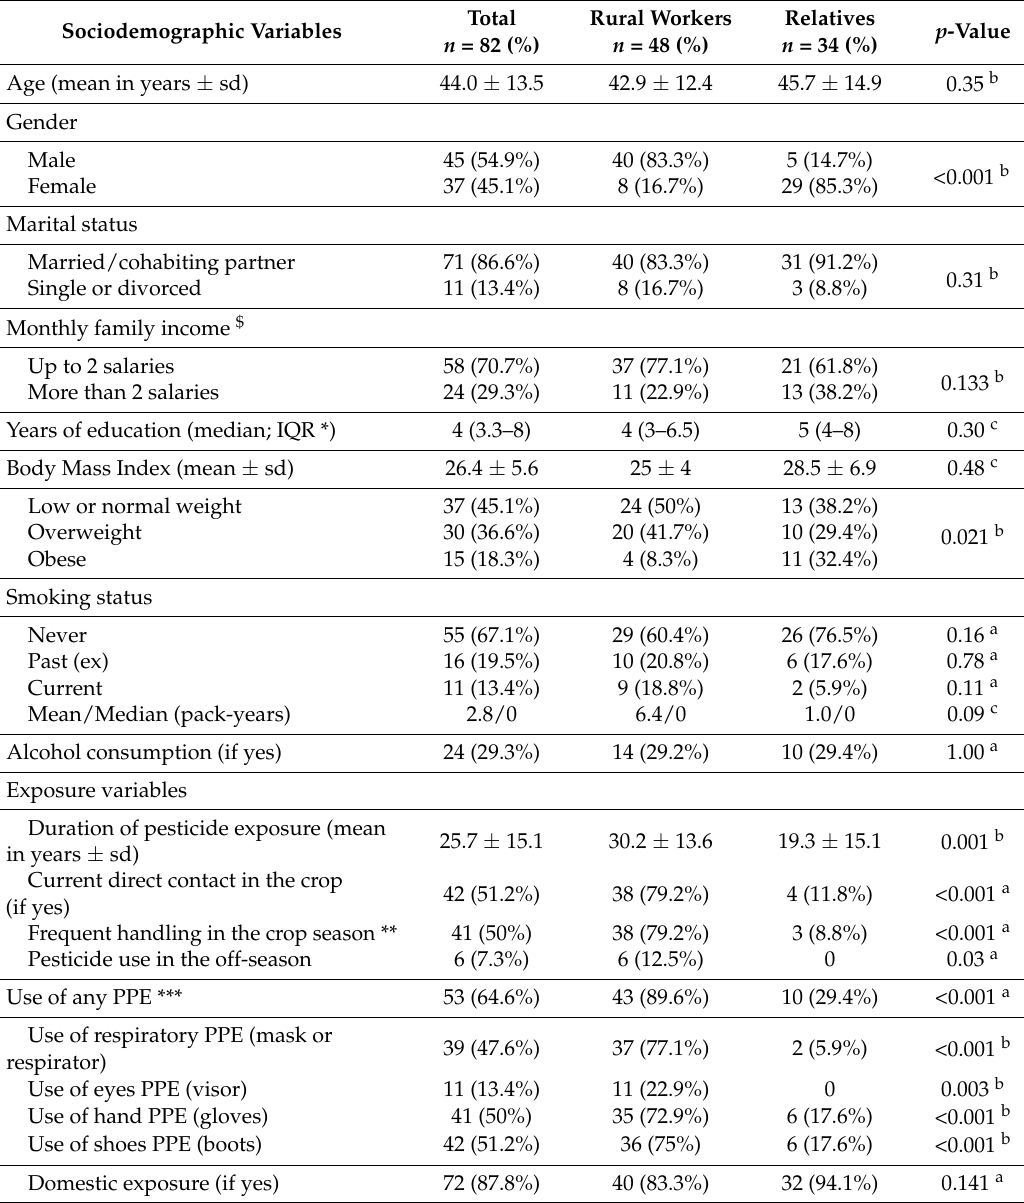
Table 1. Sociodemographic and pesticide exposure characteristics of a rural population in SJU, according to groups of